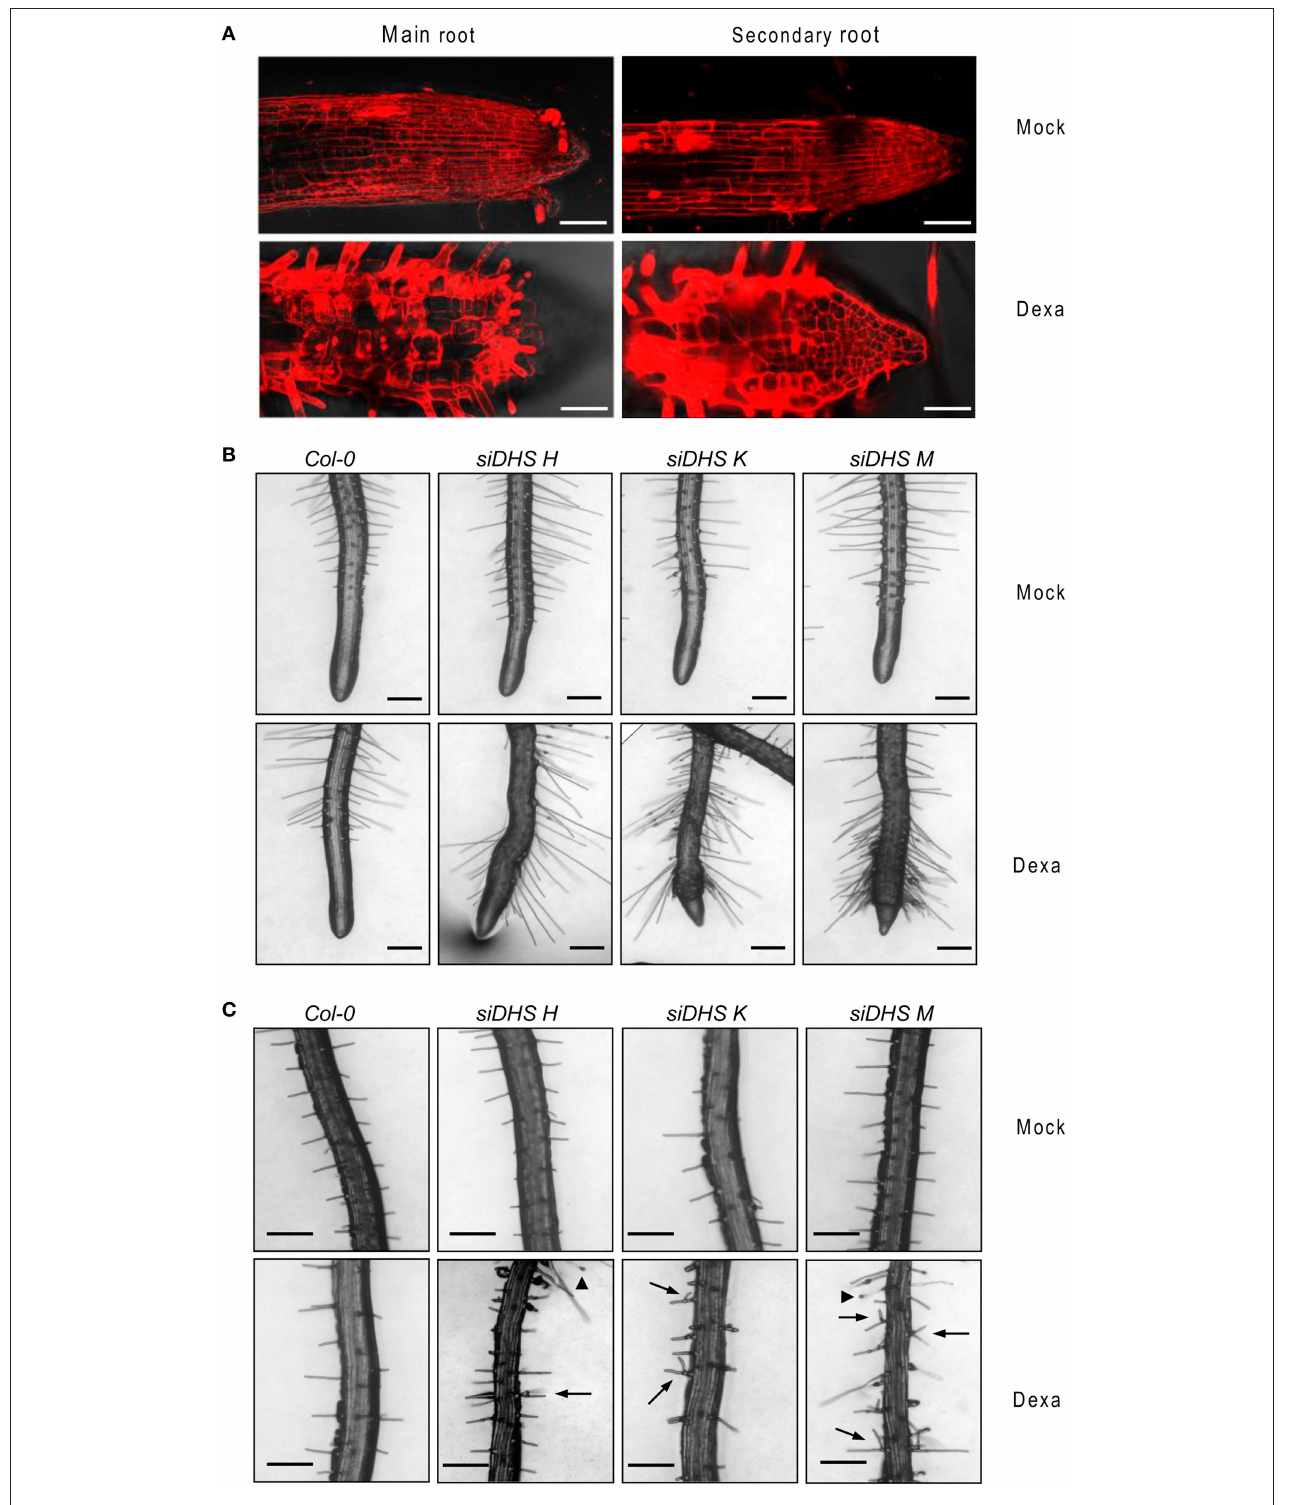
FIGURE 4 | Alterations in root cell expansion and root hair phenotypes caused by DHS silencing. (A) Confocal microscope images after propidium iodide staining of primary and secondary roots of siDHS-M plants grown in vitro for 18 days under long-day conditions with (dexa) or without (mock) dexamethasone. Scale bars represent 50 µ m. (B) Root hair pictures of 14-day-old wild type and siDHS transgenic plants grown in vitro under long-day conditions with (dexa) or without (mock) dexamethasone were taken close to the tip of secondary roots. (C) Root hair pictures were taken from the intermediate region of primary roots of the same plants as in (B) . Arrowheads and arrows mark abnormal tip swelling and branched root hairs, respectively, in silenced DHS plants. Scale bars represent 0.2mm.